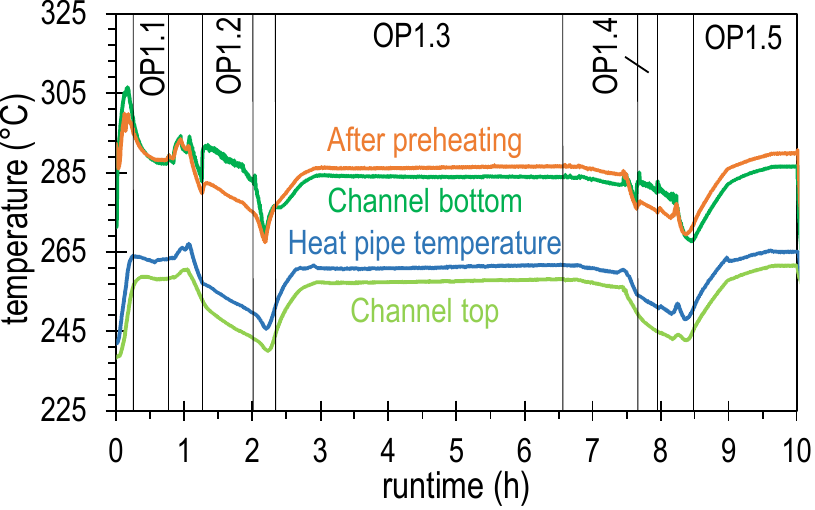
Figure 15. SC1. Temperature over runtime for selected measurements in the structured reactor of FAU_CH4_TR.